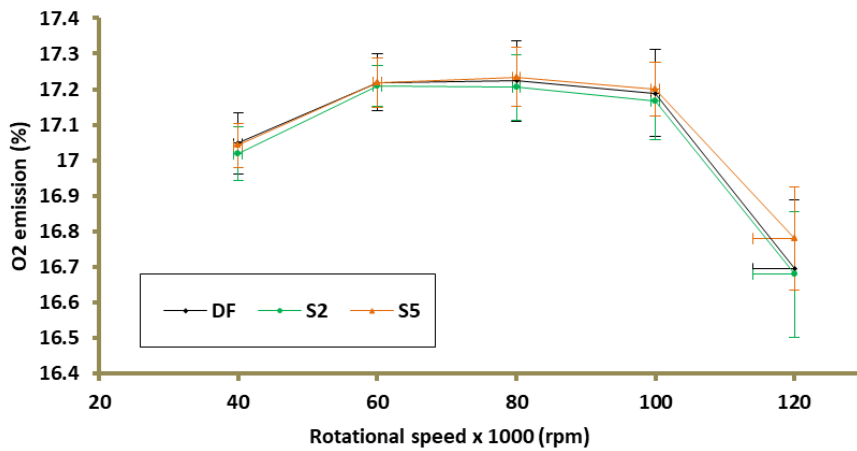
Figure 10. O2 emission as a function of rotational speed.